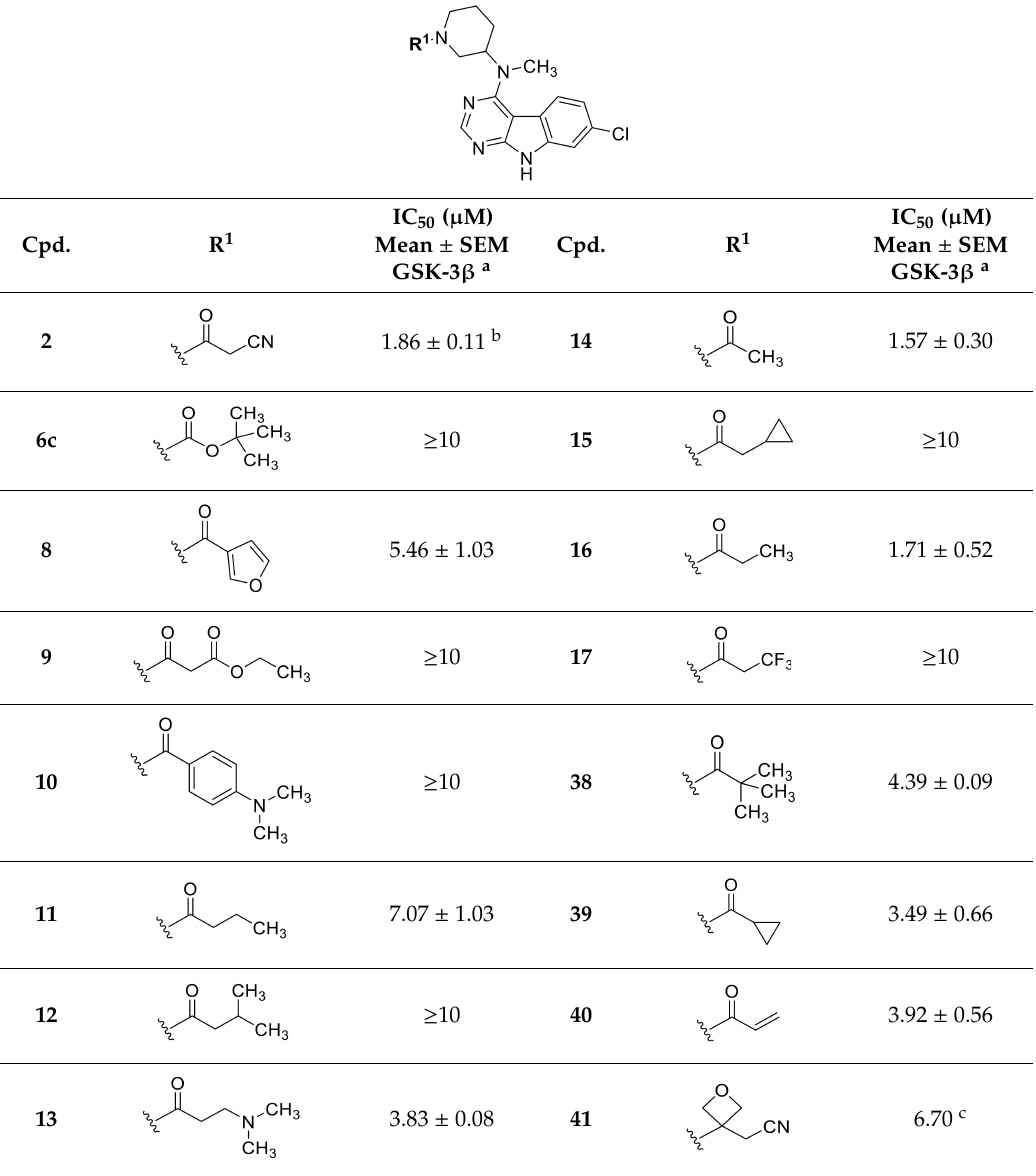
Table 1. Structures and biological activities of compounds 2 , 6c , 8 – 17 , and 38 – 41 .